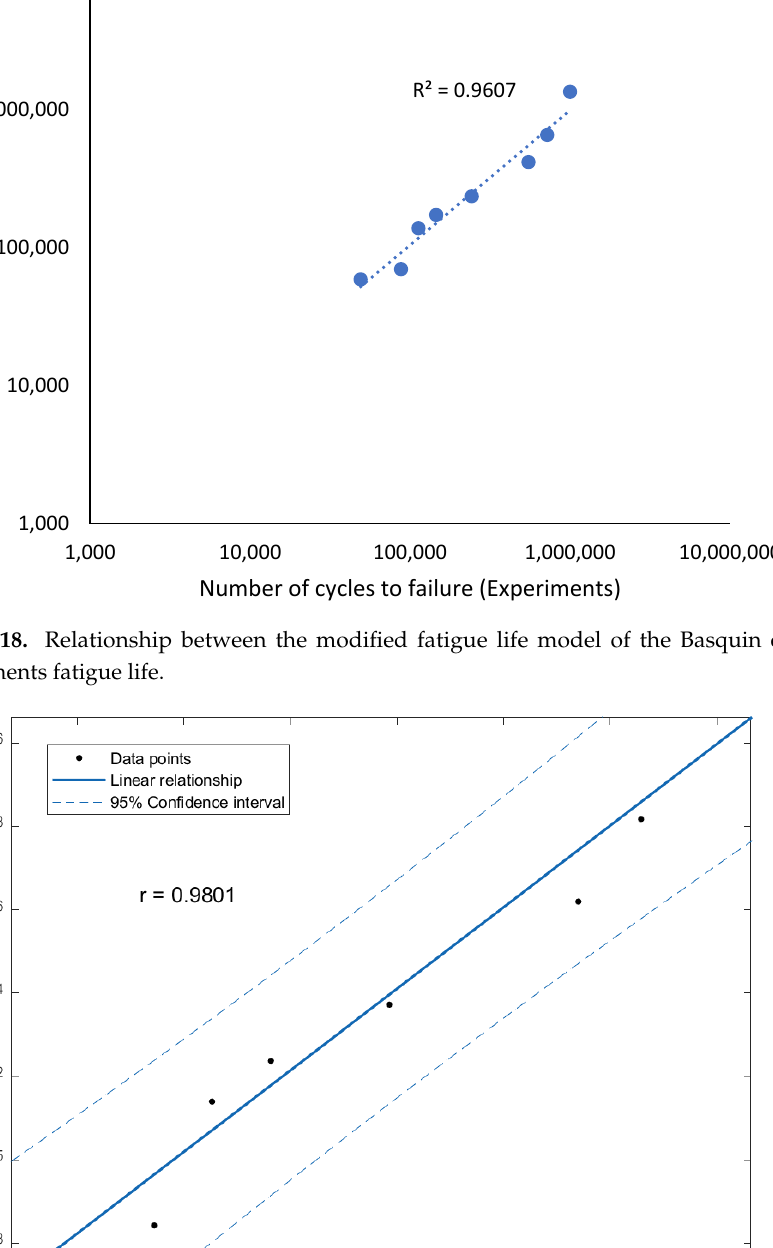
Figure 17. Correlation curve for the modified fatigue life model of the Basquin equation and exper- iments fatigue life.